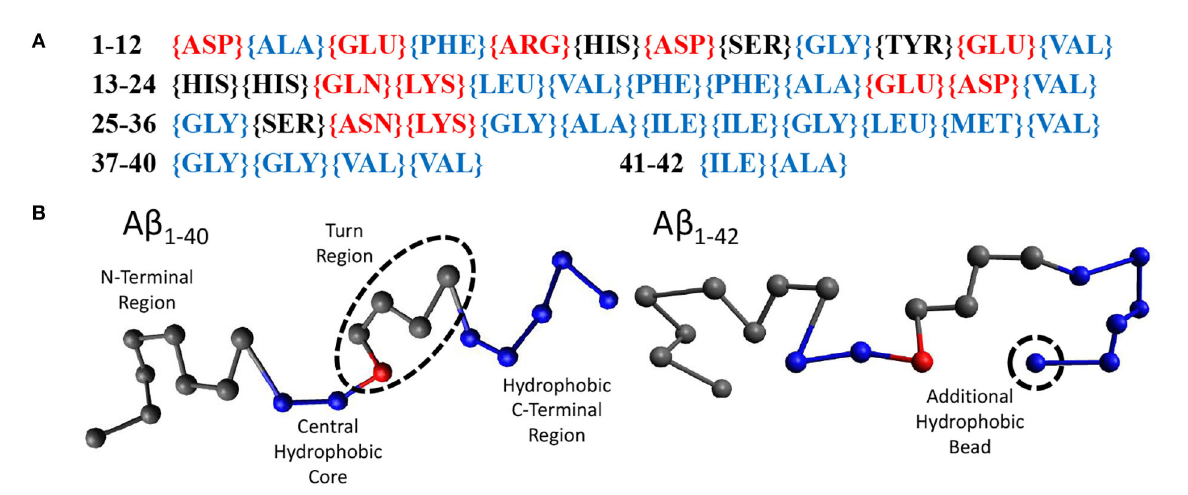
FIGURE2 (A) The amino acid sequence of A β 1 . Amino acids labeled red are hydrophilic, black are neutral, and blue are hydrophobic. (B) Our beads on a − 42 string model for both A β 1 and A β 1 with the N-terminus to the C-terminus going from left to right. Each bead represents 2 amino acids. − 40 − 42 Gray beads are inert, representing the N-terminus (1–16) and the turn region (24–27). Blue beads are hydrophobic, representing the